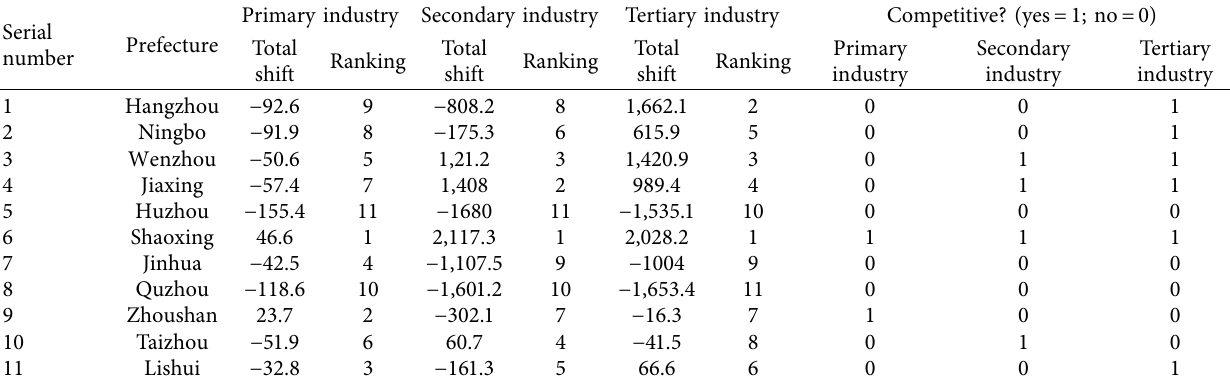
Table 2: Total shifts of the three industries in each prefecture and their